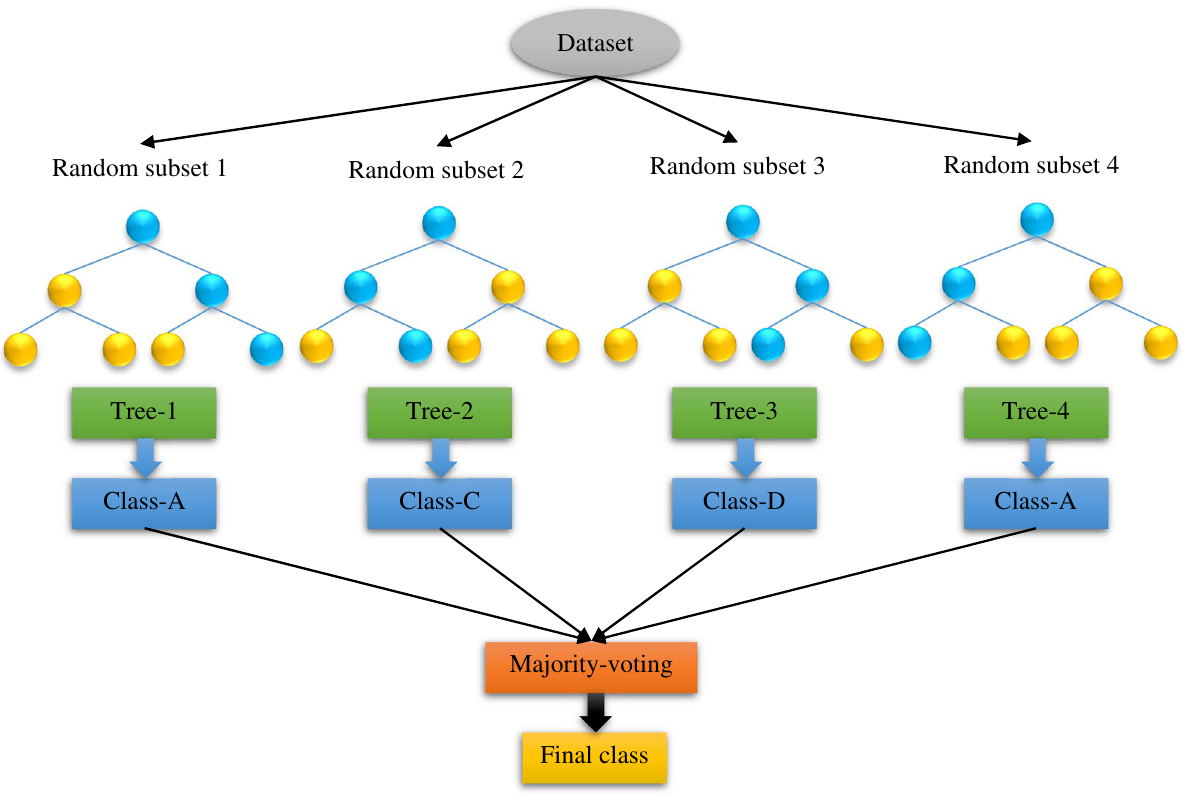
Figure 3. A schematic of the random forest